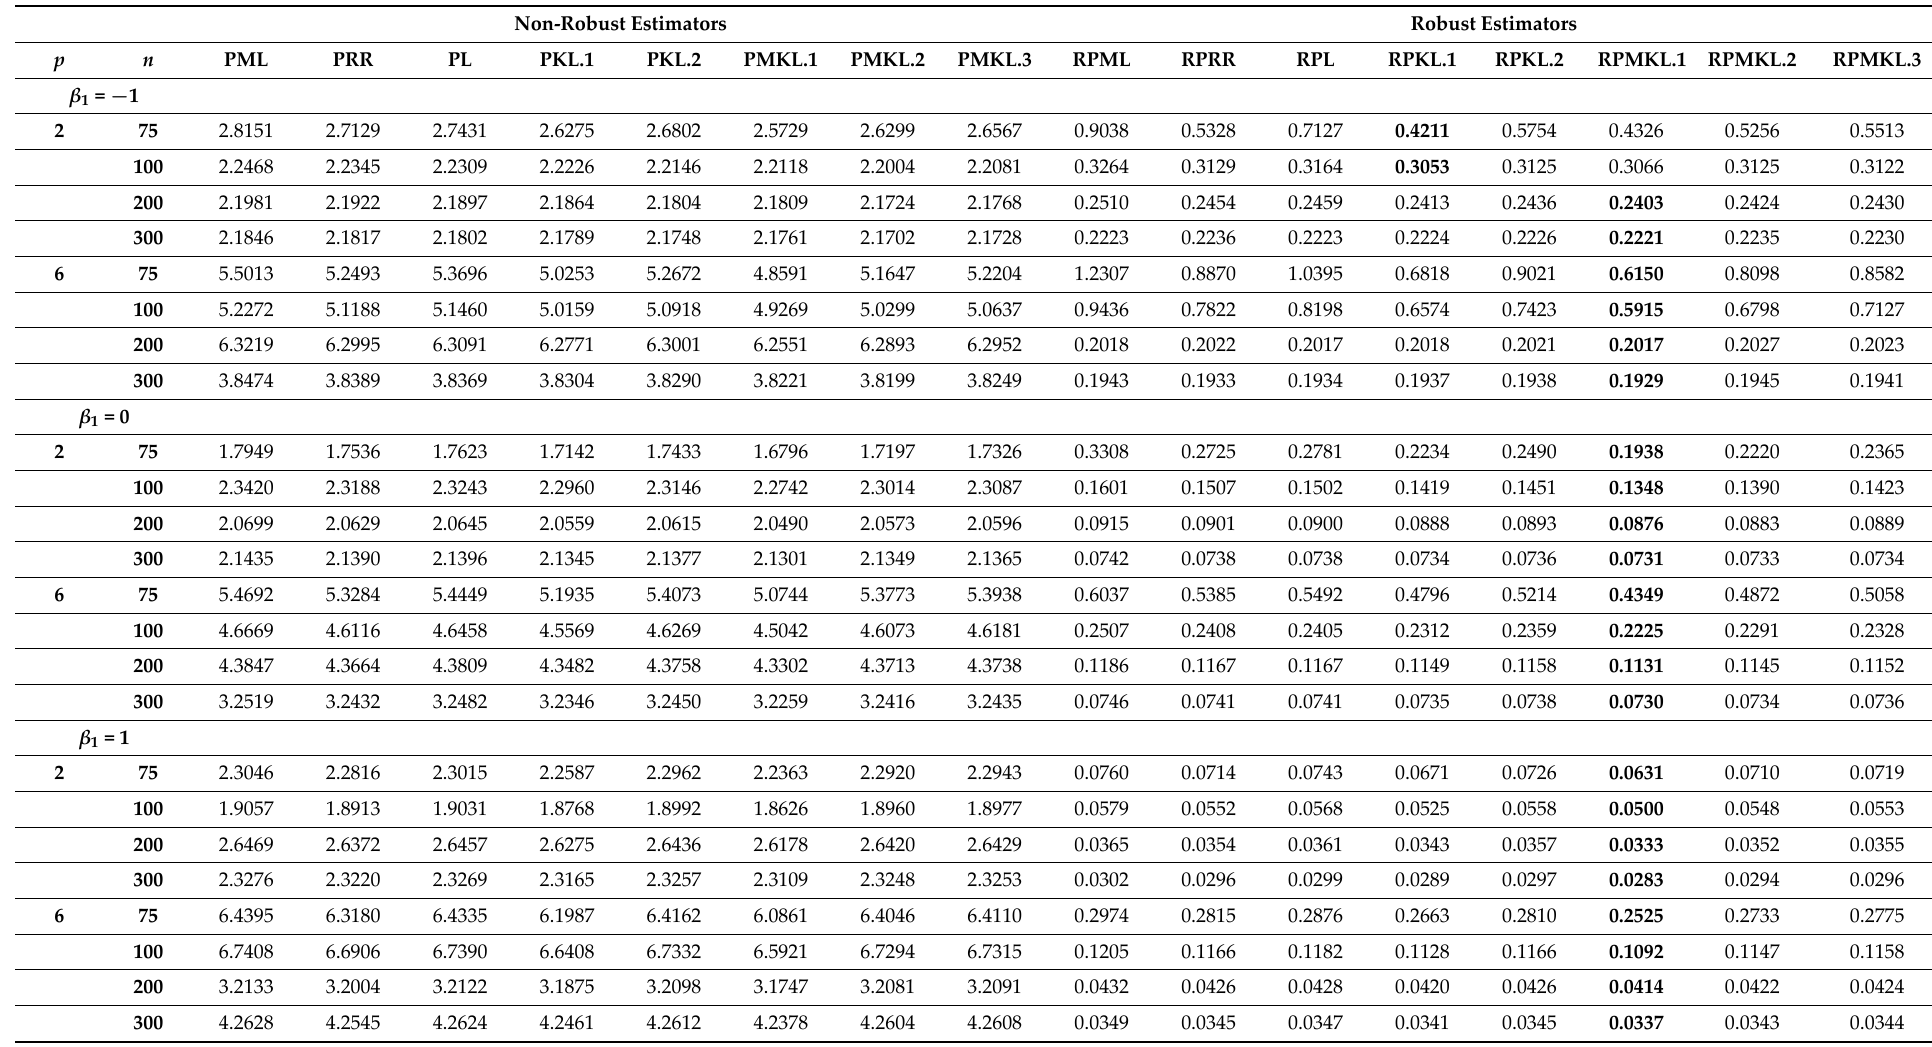
Table A4. AMSE of different estimators when τ = 10% and ρ =